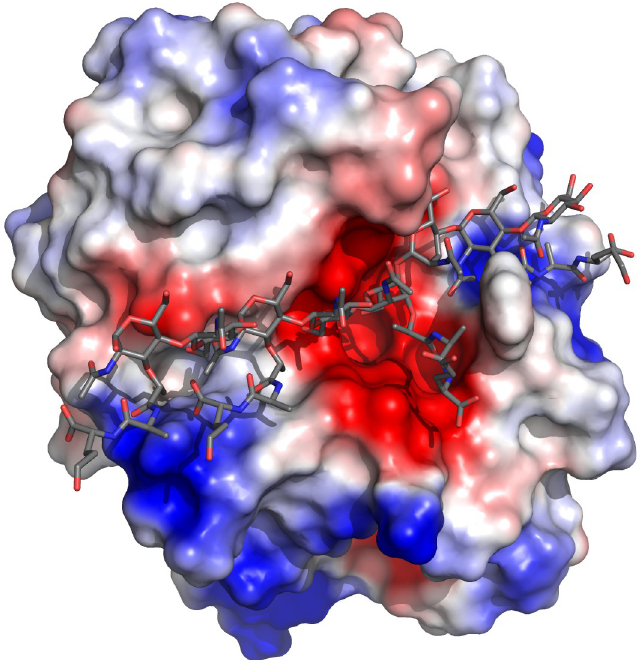
Fig 9. Model of ligand binding by AaMur. The surface of Aa Mur is shown. The ligand model was created by superposition of the Aa Mur structure and the 2WWD template to position the first sugar of the substrate. Three additional sugars were then placed using Pymol with the dihedrals adjusted to remove clashes as far as possible, while maintaining the coordinates of the substrate fragment resolved in 2WWD.